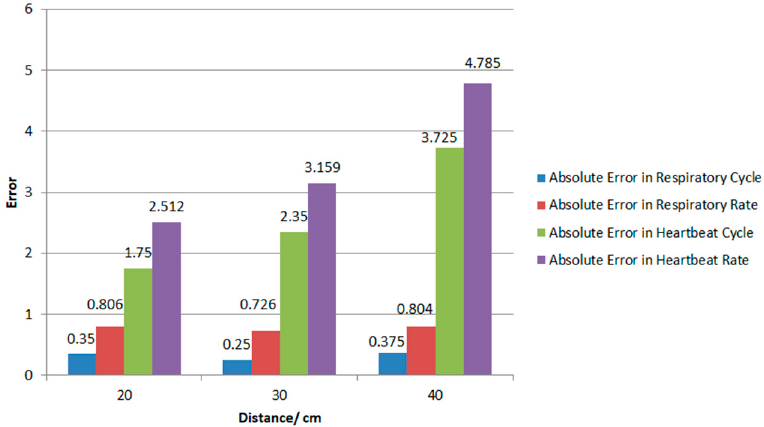
Figure 11. Error analysis of three different distances.